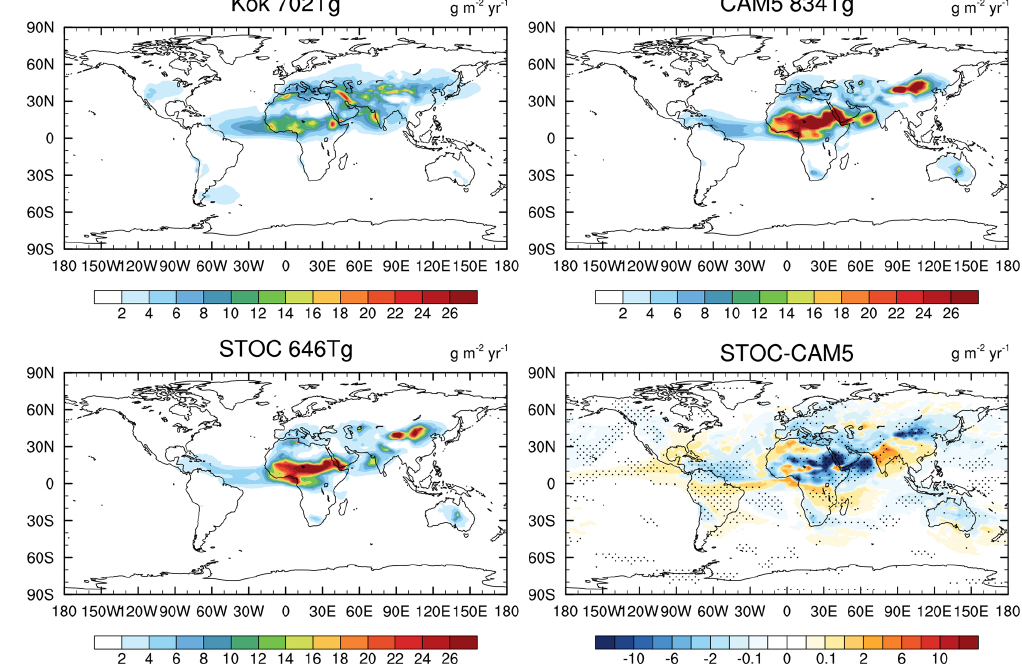
Figure 7. Global distributions of dust wet deposition in Kok et al. (2021), CAM5 and STOC and the difference between STOC and CAM5. Values are the annual total amount of dust wet deposition over the